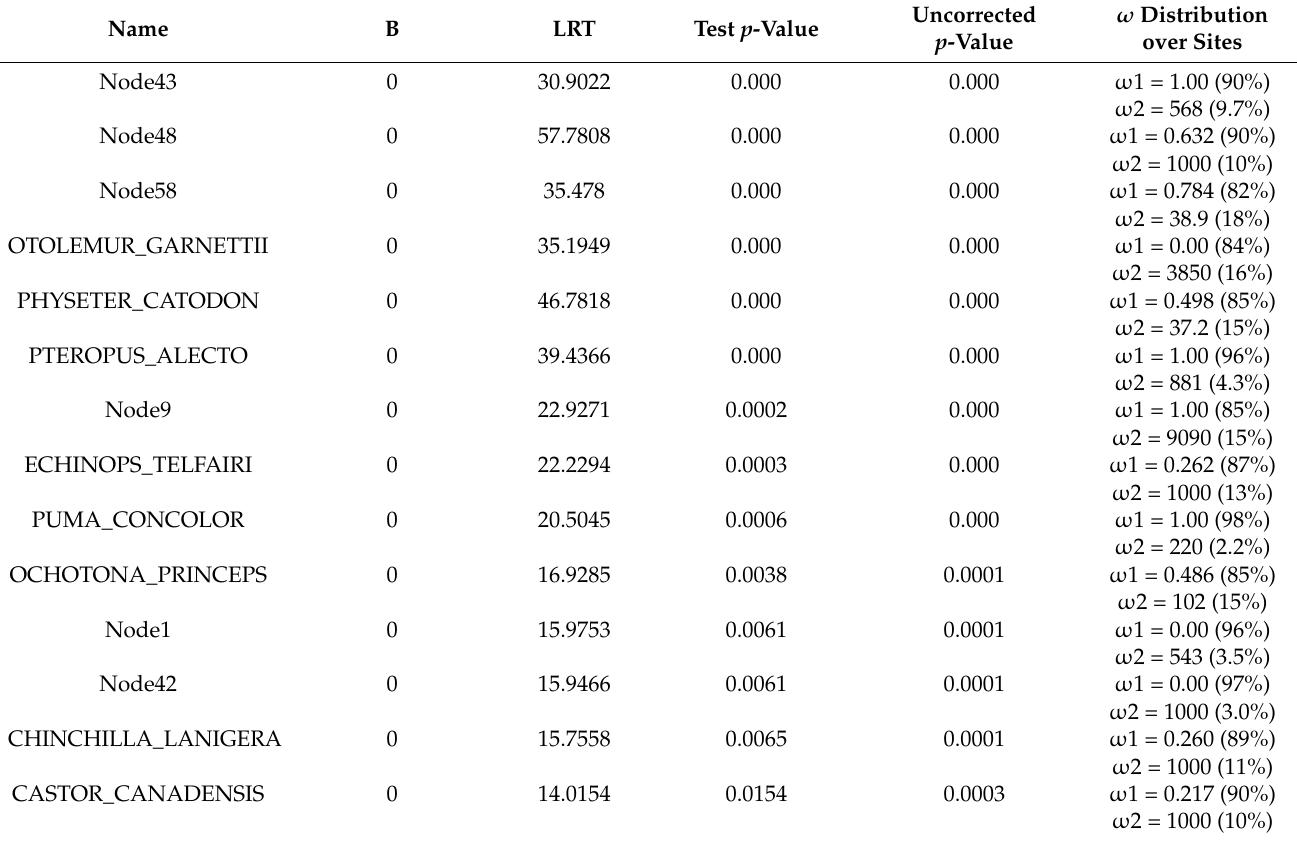
Table 4. Sites under episodic diversifying selection inferred adaptive Branch Site REL (aBS- REL